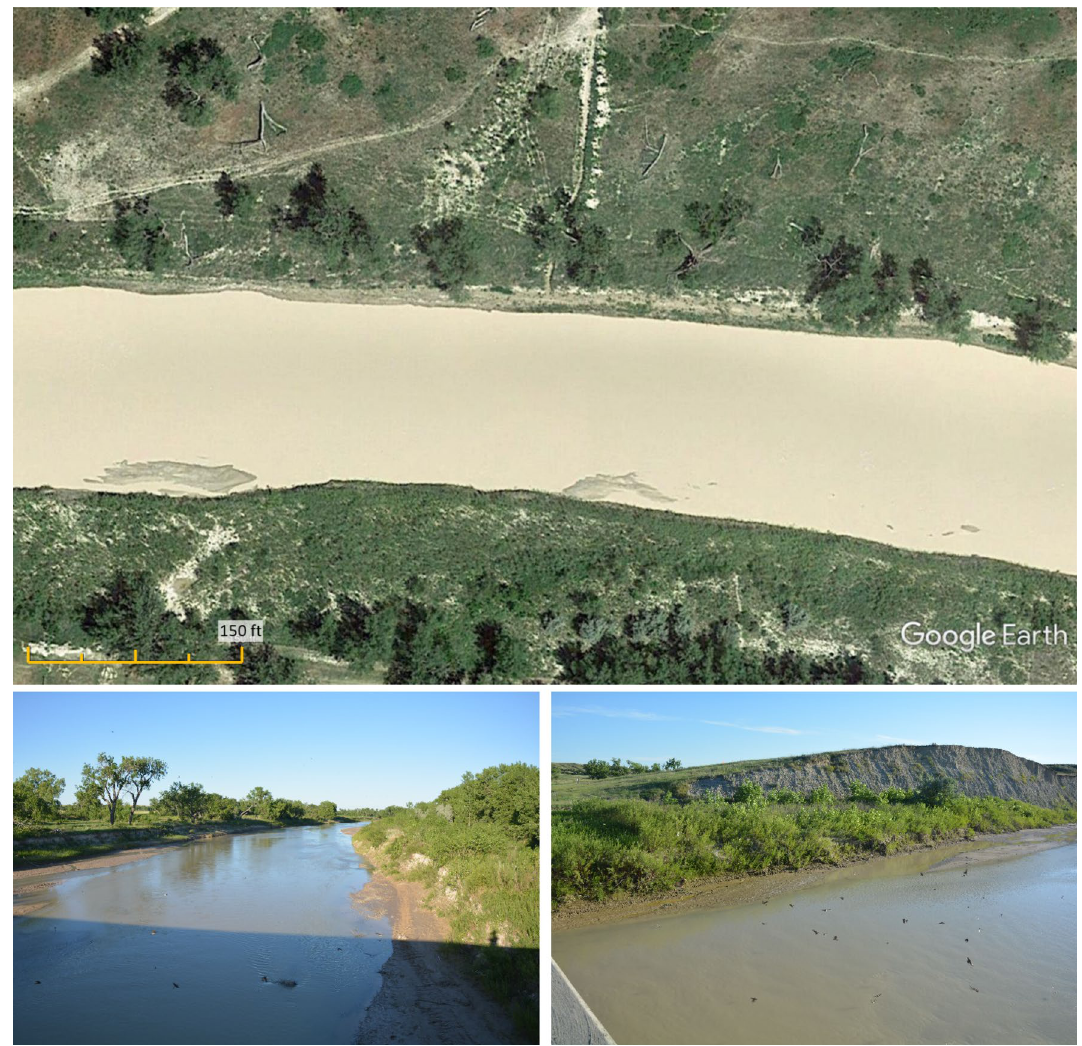
Figure 5. White River at Interior, South Dakota, USA (top image: Maps Data: Google, © 2022, lower images: own